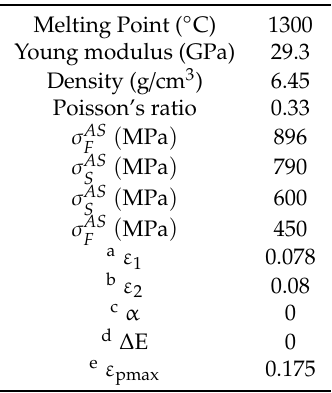
Table 2. Properties of NiTi shape memory alloy [48].